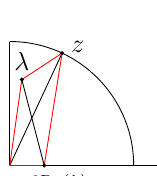
Fig. 3. Case ' < (cid:18) (cid:20) (cid:25)=2